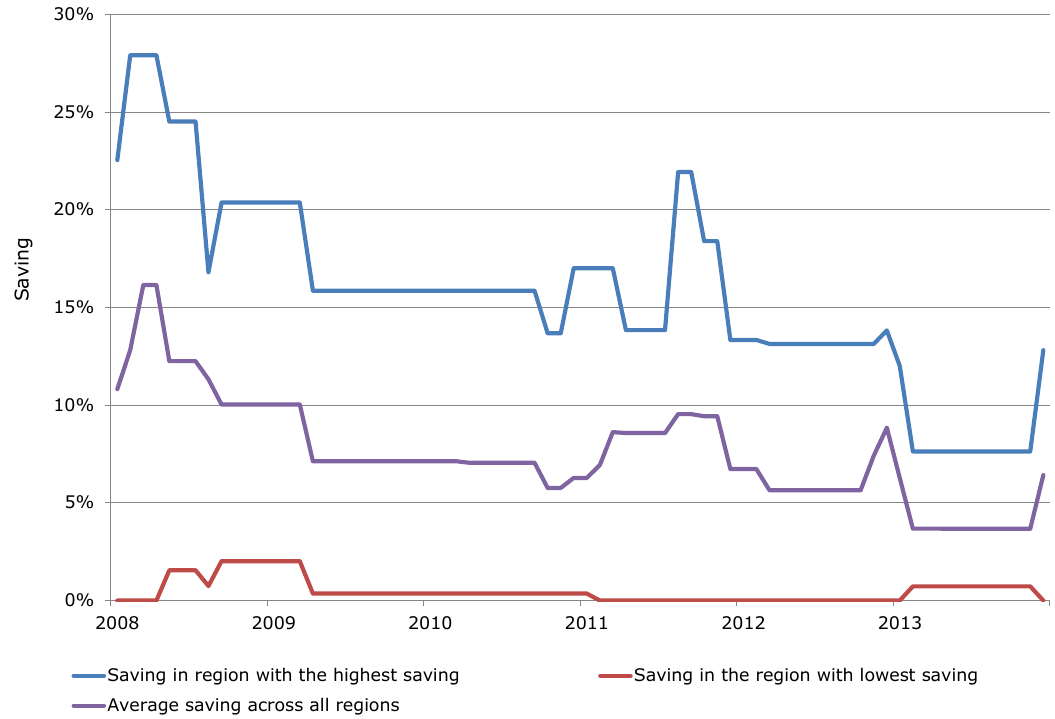
Figure 21: Savings available to single-fuel customers paying by standard credit, from switching to the best equivalent offering from the largest six suppliers (highest, average and lowest regional